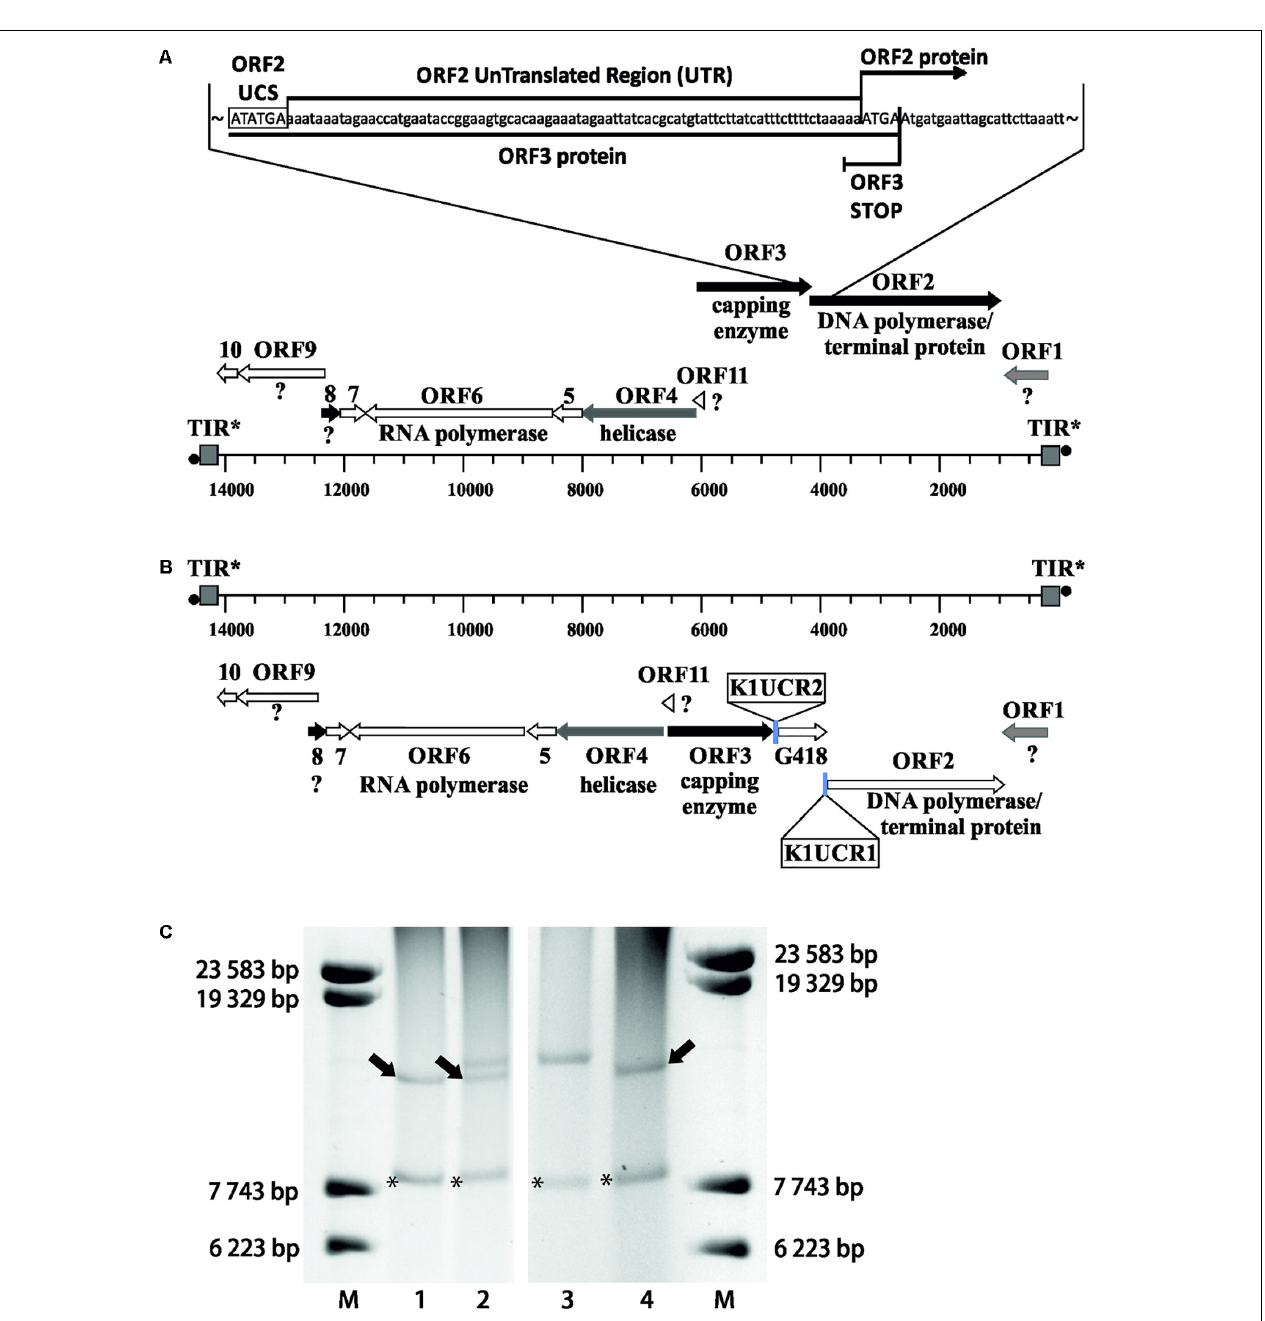
FIGURE 5 | Precise manipulation of pGKL VLEs in vivo revealed an essential role of pGKL promoters in mRNA capping and non-template-based 5 (cid:48) polyadenylation. (A) A closer view of the native pGKL2 region subjected to homologous recombination with a PCR cassette depicted in Supplementary Figure S5 shows a tightly packed VLE genome. The 3 (cid:48) end of the K2ORF3 coding region overlaps the K2ORF2 promoter, 5 (cid:48) UTR, and the first four nucleotides of the K2ORF2 coding region. The pGKL2 VLEs displayed in (B,C) are in the reverse orientation of those in Figure 1 . Shades of gray indicate the degree of transcript capping, as shown in Figure 1 . (B) A PCR cassette containing an antibiotic resistance gene (G418) under the control of the ORF2 promoter from pGKL1 ( K1UCR2 ) and the ORF1 promoter from pGKL1 ( K1UCR1 ) ( Supplementary Figure S5 ) was inserted into the K2ORF2 promoter region by homologous recombination in vivo . The resulting VLE, pRKL2-1, contains two genes, aminoglycoside 3 (cid:48) -phosphotransferase (coding for G418 resistance) and K2ORF2 , that are artificially controlled by the pGKL1 promoters K1UCR2 and K1UCR1 , respectively. Shades of gray indicate the degree of transcript capping, as shown in Figure 1 . The 5 (cid:48) RACE results of pRKL2-1-encoded mRNAs are summarized in the text and in Supplementary Table S7 . (C) Electrophoretic analysis of pGKL VLEs in K. lactis clones. M, lambda DNA/ Eco 130I ( Sty I) marker (Fermentas); lanes 1 and 4, native pGKL VLEs from K. lactis IFO1267 (pGKL1 [8874 bp] is labeled with an asterisk, and pGKL2 [13447 bp] is labeled with an arrow); lane 2, linear VLEs purified from K. lactis IFO1267 carrying both the recombinant (higher MW) and wild-type pGKL2 VLEs; lane 3, linear VLEs purified from K. lactis IFO1267 containing the recombinant pRKL2-1 VLE (14353 bp). The shorter wild-type pGKL2 was lost after cultivation for ≈ 60 generations in selective medium containing